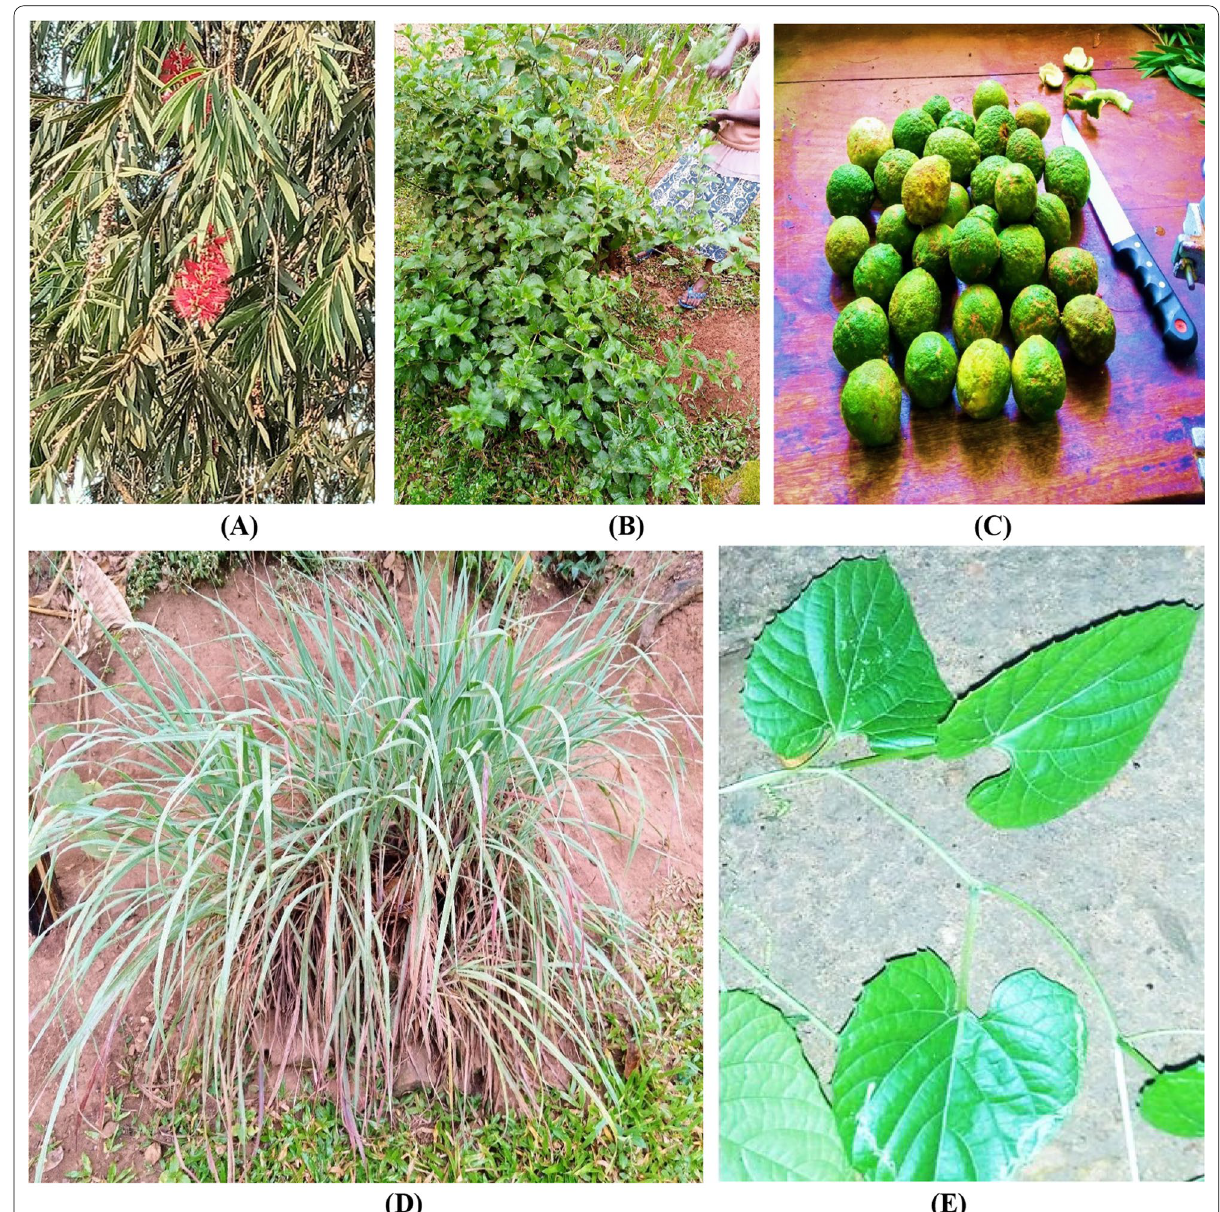
Fig. 3 Some frequently used plant species in the management of diarrhea and/or cough in Kampala city. A C. citrinus ; B C. pyrrhopappa ; C C. limon fruits; D C. flexuosus ; E M.